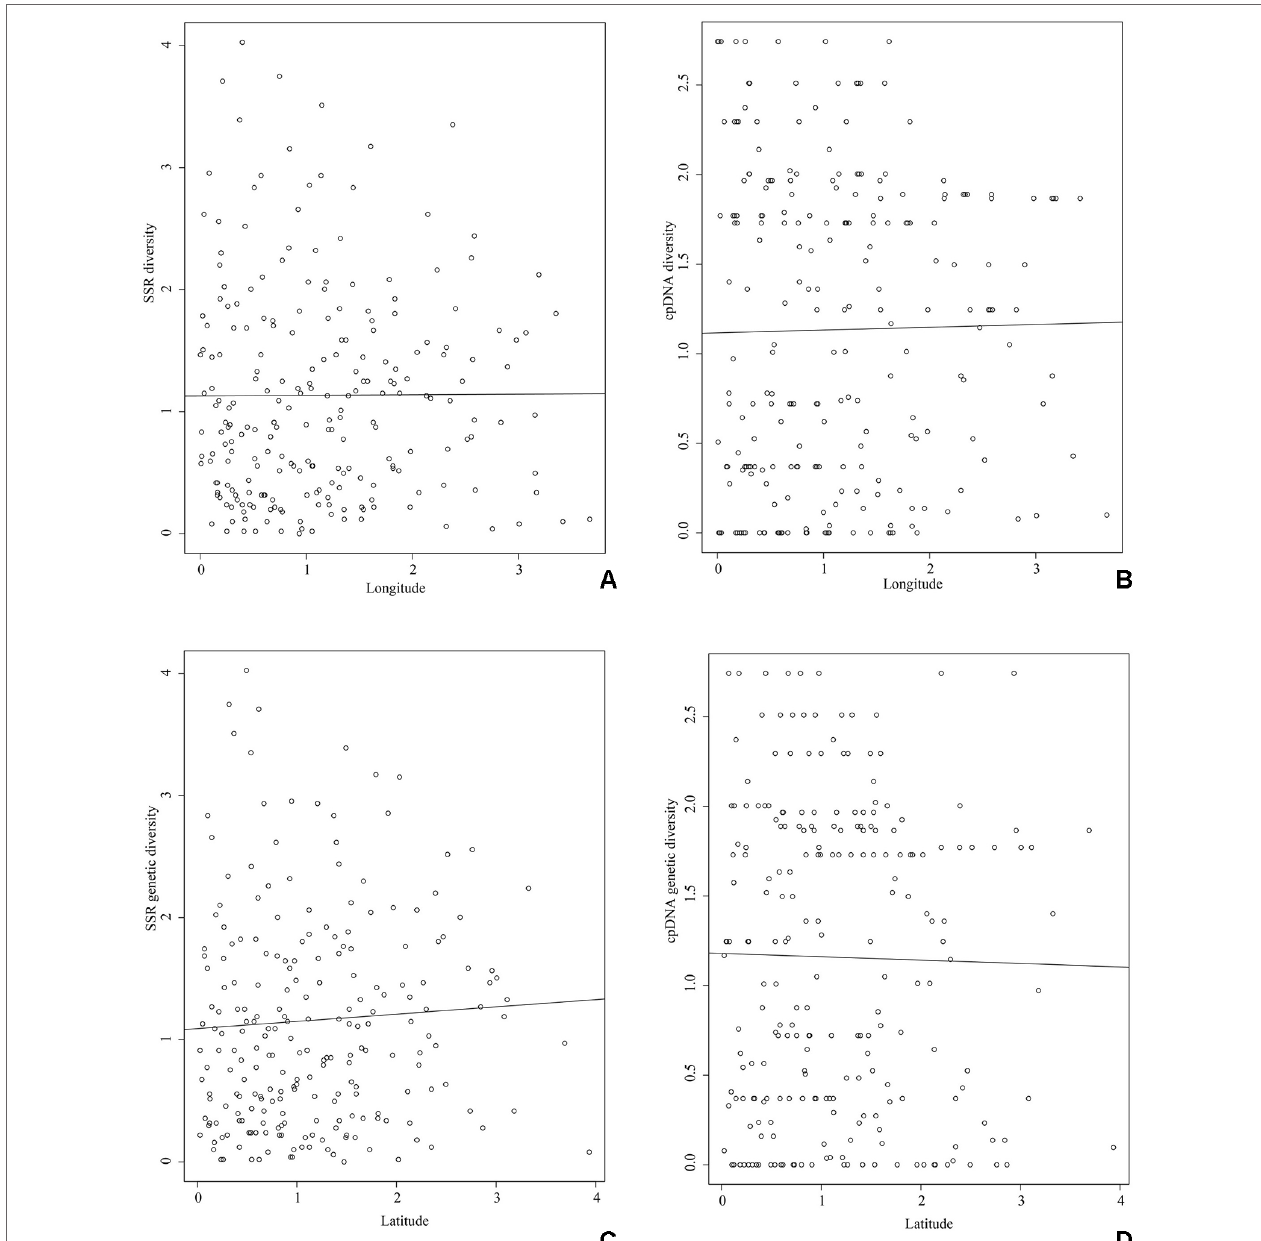
FIGURe 2 | Mantel test between genetic diversity and longitude and latitude. The X axis represents genetic diversity of SSR (A and C) and cpDNA (B and D) after standardization. The Y axis represents longitude (A and B) and latitude (C and D) after standardization. (A) Genetic diversity of SSR along longitude, (B) genetic diversity of cpDNA along longitude, (C) genetic diversity of SSR along latitude, (D) genetic diversity of cpDNA along latitude.